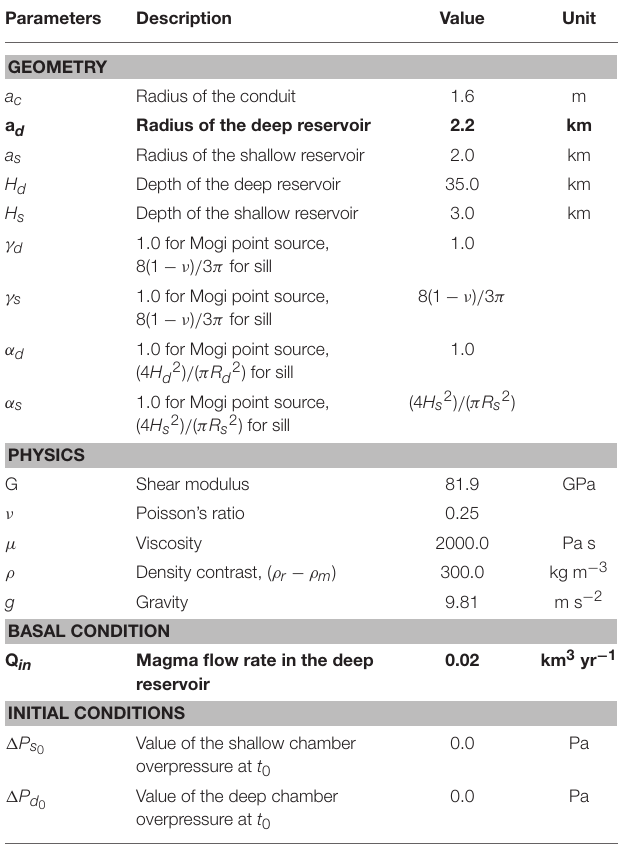
TABLE 1 | Model parameters and true values assigned for the synthetic case.